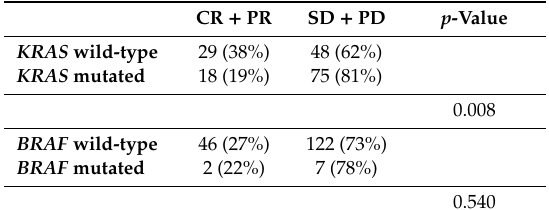
Table 4. Statistical association between KRAS and BRAF mutational status and treatment response to standard